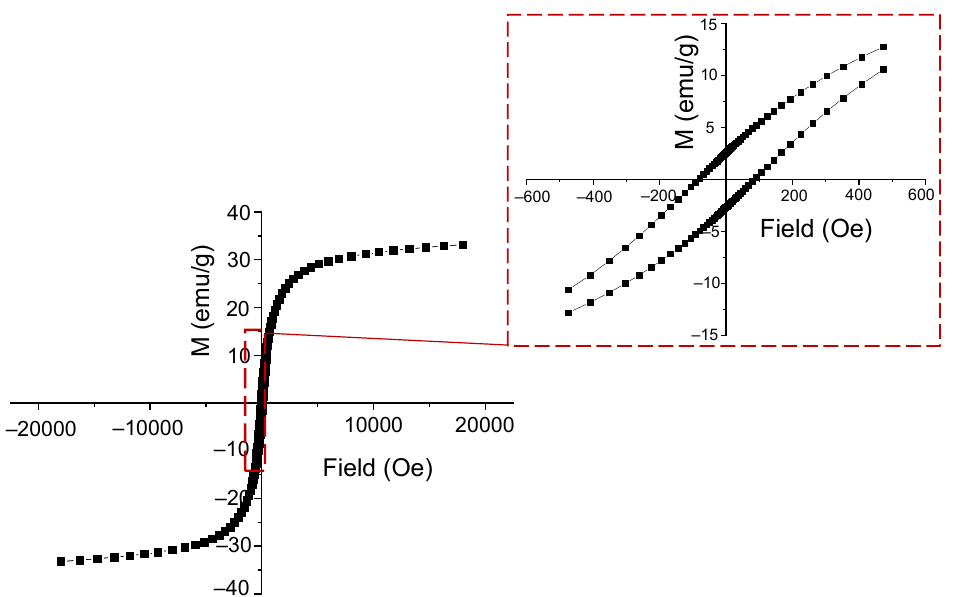
Figure 8. Magnetic hysteresis loop of Ni 36 Al 27 Co 37 powder after PS.